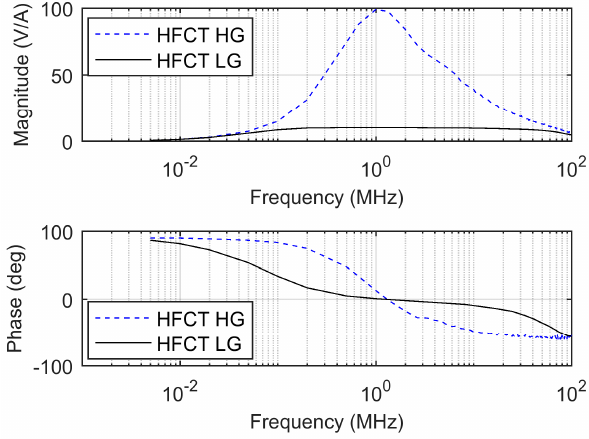
Figure 15. Comparison of Bode plots of the HFCT_LG and the HFCT_HG sensors.